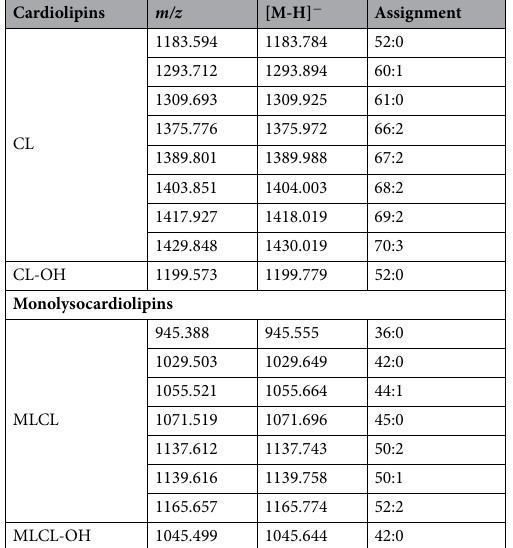
Table 2. Lipid assignments of m/z values in MALDI –TOF ( − ) spectra of the cardiolipins and monolysocardiolipins of the total lipid extract of Acinetobacter baumannii . The numbers (x:y) denote the total length (as carbon numbers) and number of double bonds of both acyl chains